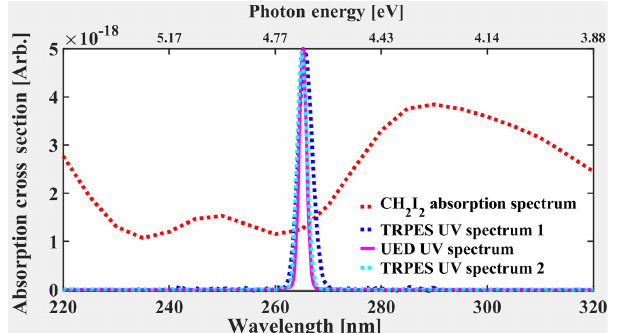
FIG. 6. CH 2 I 2 absorption spectrum, together with the spectra for the pump pulses in the two experiments. The UV spectrum in the TRPES measurement is centered at 265.6 nm, while the UV spectrum of the UED measurement is centered at 265.3 nm. As the TRPES measurements were repeated with two different apparatuses, the spectrum for each of these pump pulses is shown